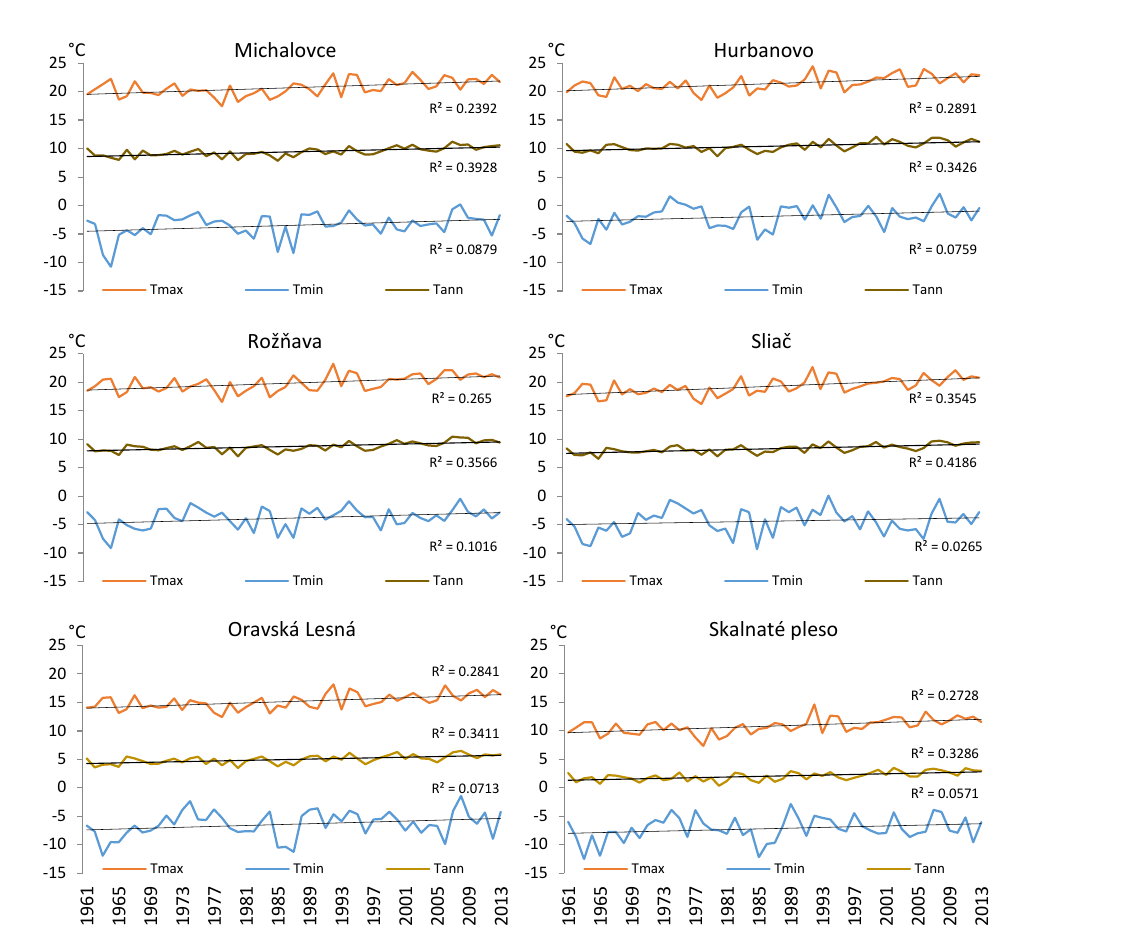
Figure 3. Linear trends of the annual mean temperature ( T ann ), monthly mean temperatures of the coldest ( T min ) and warmest month ( T max ) at stations used in the